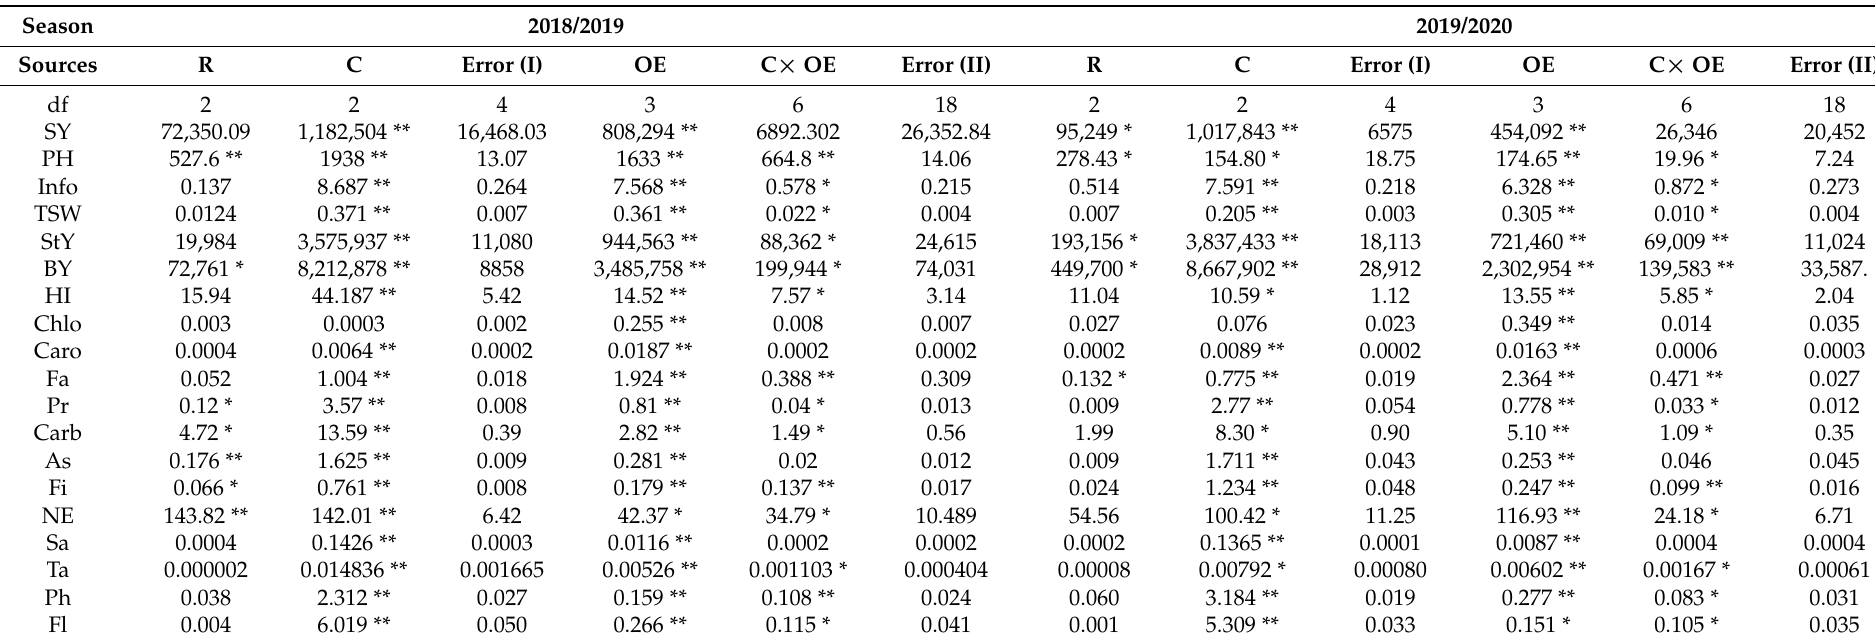
Table 5. Mean squares of source of variation for split-plot design for studied traits of quinoa cultivars (C) and the organic extracts (OE) tested at 2018/2019 and 2019/2020 seasons.